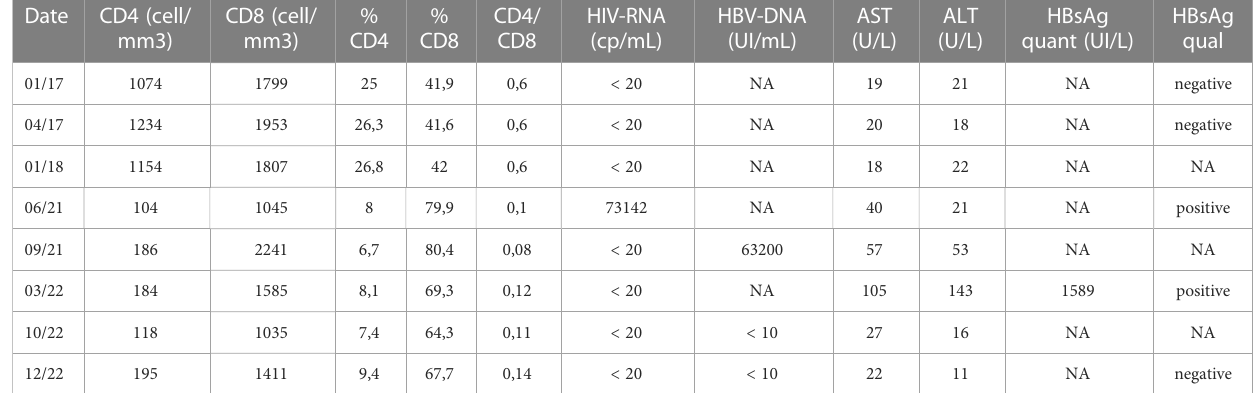
TABLE 1 HIV and HBV viral and immunological markers before the loss of care and after the